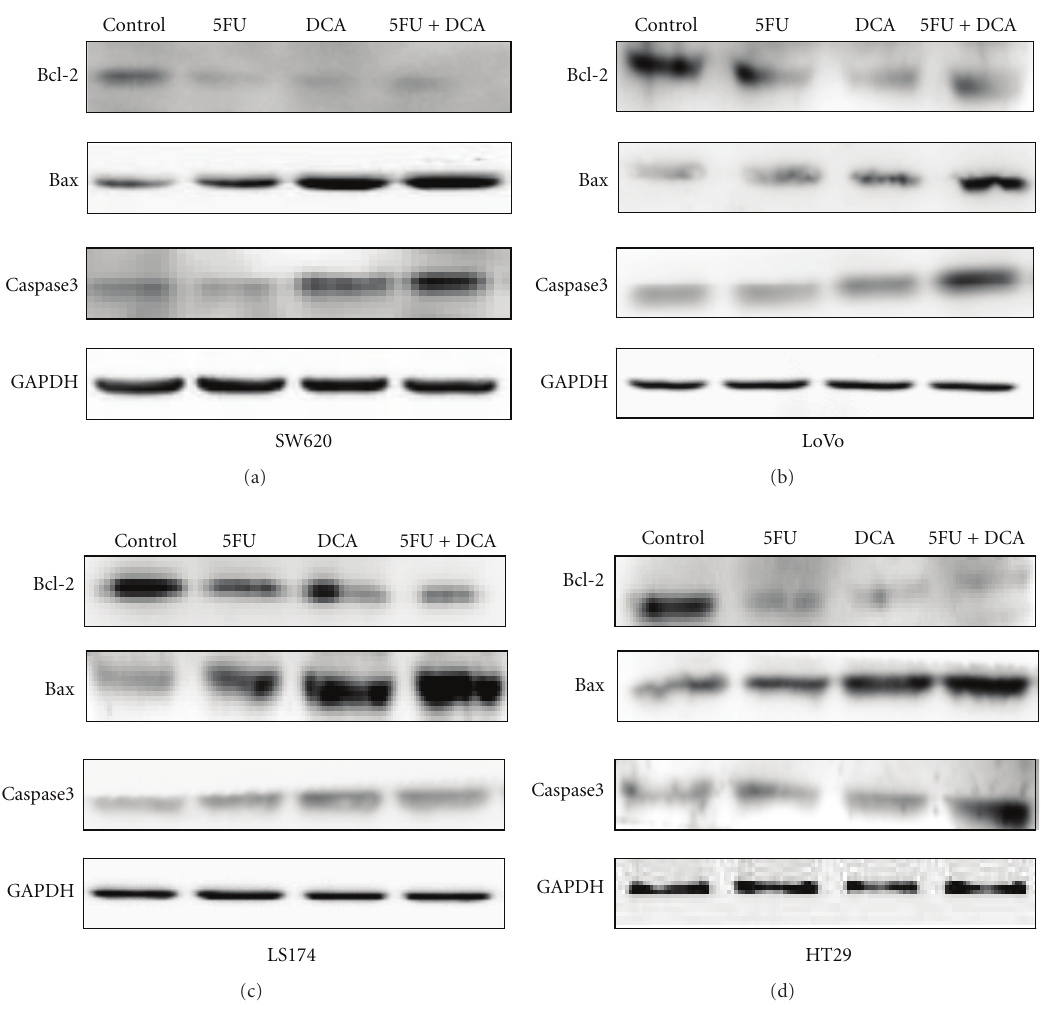
Figure 5: E ff ects of 5-fluorouracil (5-FU) and dichloroacetate (DCA) on apoptosis-associated molecules expression. Bcl-2 expression was significantly decreased by DCA in SW620, LoVo, and LS174t and HT29 cells. Bax and caspase-3 expression levels were higher after exposure to 5-FU and DCA compared with